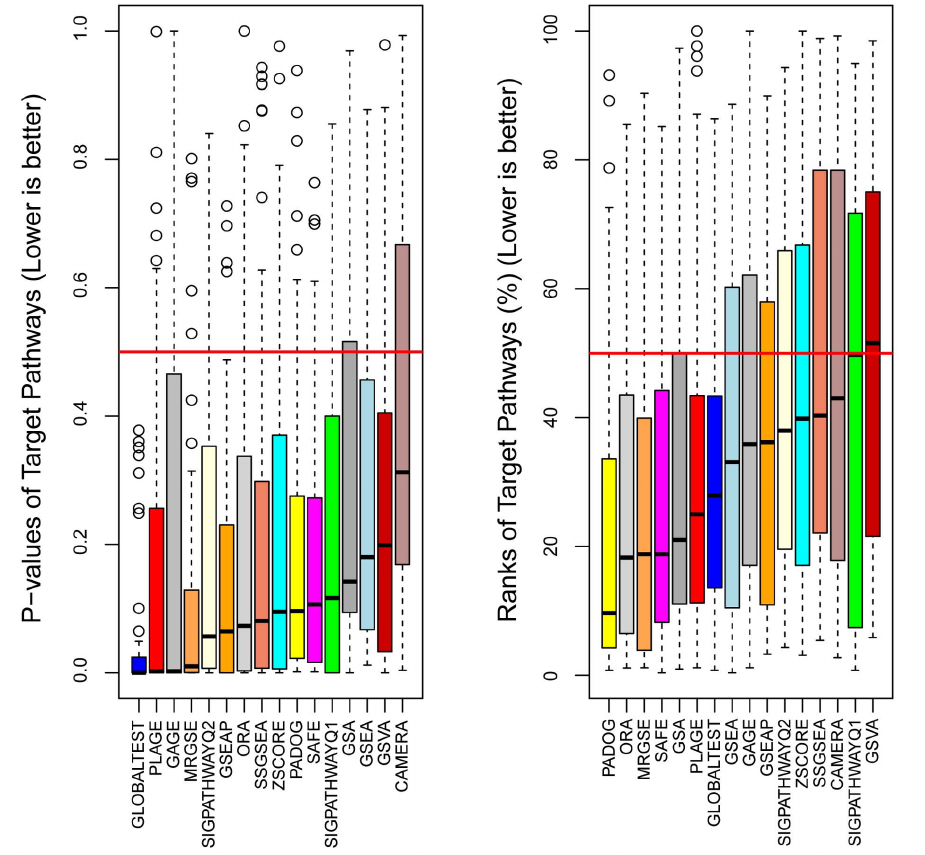
Figure 2. A comparison of sensitivity and prioritization ability of 16 gene set analysis methods. Each box contains 42 data points representing the p-value (left) and the rank (%) (right) that the target pathway received from a given method when using as input an independent dataset and a collection of gene sets (either KEGG or Metacore). Since the target pathways were designed by KEGG and Metacore for those diseases we expected that, in average, they will be found relevant by the different methods. Methods are ranked from best to worst according to the median p-value (left) and median rank (right).